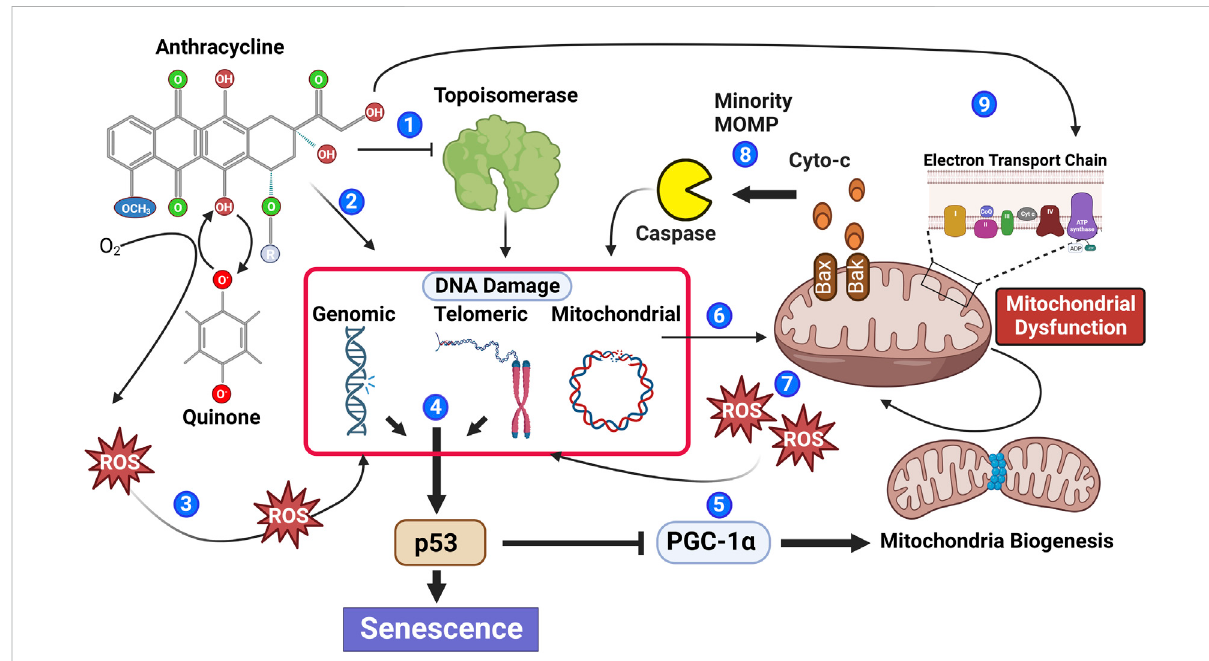
FIGURE 1 Anthracyclines contribute to multiple biological processes that stimulate senescence. Anthracyclines can inhibit the enzymatic function of topoisomerase leading to irreversible DNA damage (1) and through DNA intercalation induce DNA damage independent of topoisomerase (2). Moreover, the quinone structure of anthracyclines can be oxidized to a semiquinone radical through the addition of an electron. Semiquinone radicals quickly react with oxygen to generate ROS causing DNA damage (3). DNA damage within the genomic or telomeric chromosomal regionsleadstoactivationoftheDNAdamageresponsepathway,whichifpersistentcontributestophosphorylationofthekeysenescenceregulator p53 (4). Phosphorylated p53 inhibits PGC-1a attenuating mitochondrial biogenesis (5). Reduced mitochondrial biogenesis in combination with anthracycline-mediated mitochondrial DNA damage (6) leads to an accumulation of mitochondrial dysfunction and increased ROS generation, contributing to additional DNA damage (7). Mitochondrial outer membrane permeability (MOMP) is also increased in dysfunctional mitochondria allowing the release of caspase-activating cytochrome C; if insuf fi cient to induce apoptosis, the sub-lethal activation of caspase will cause further DNA damage (8). Recently, it has also been suggested that anthracyclines can cause biogenetic lesions to the electron transport chain (Tarpey et al., 2019), further contributing to increased ROS